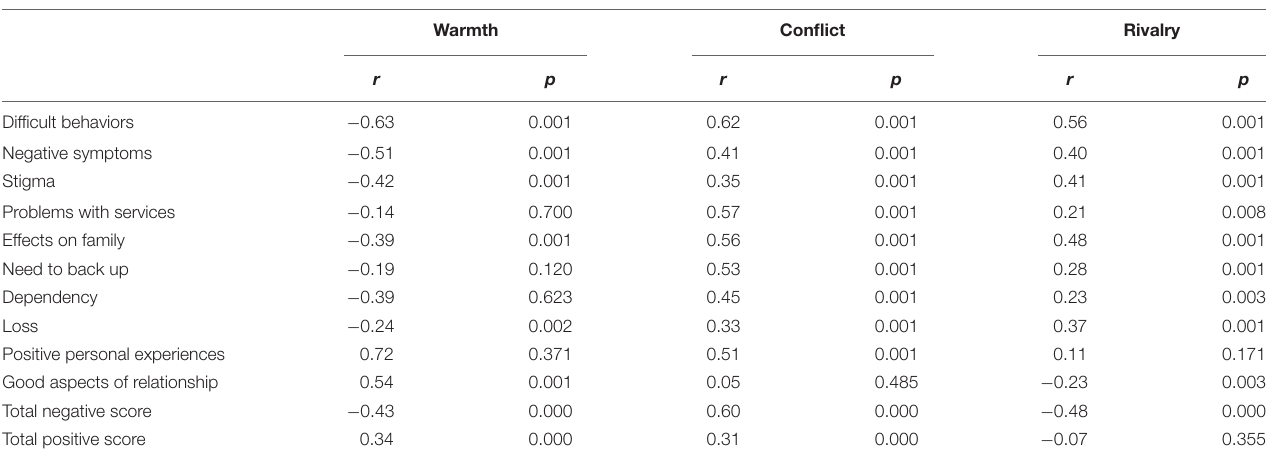
TABLE 4 | The experience of caregiving and the sibling